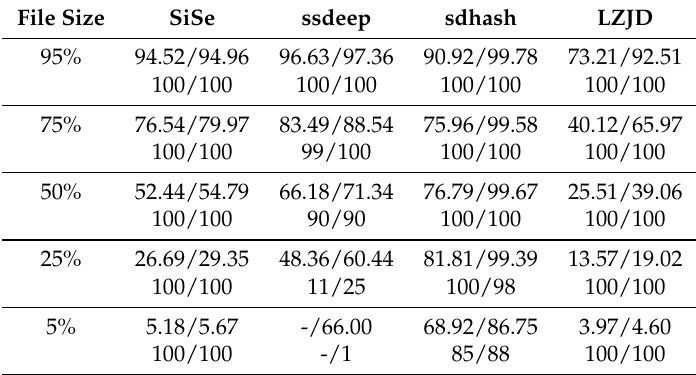
Table 30. Fragment detection test with two cutting modes (random start/end only) and number of matches in each case. File Size SiSe ssdeep